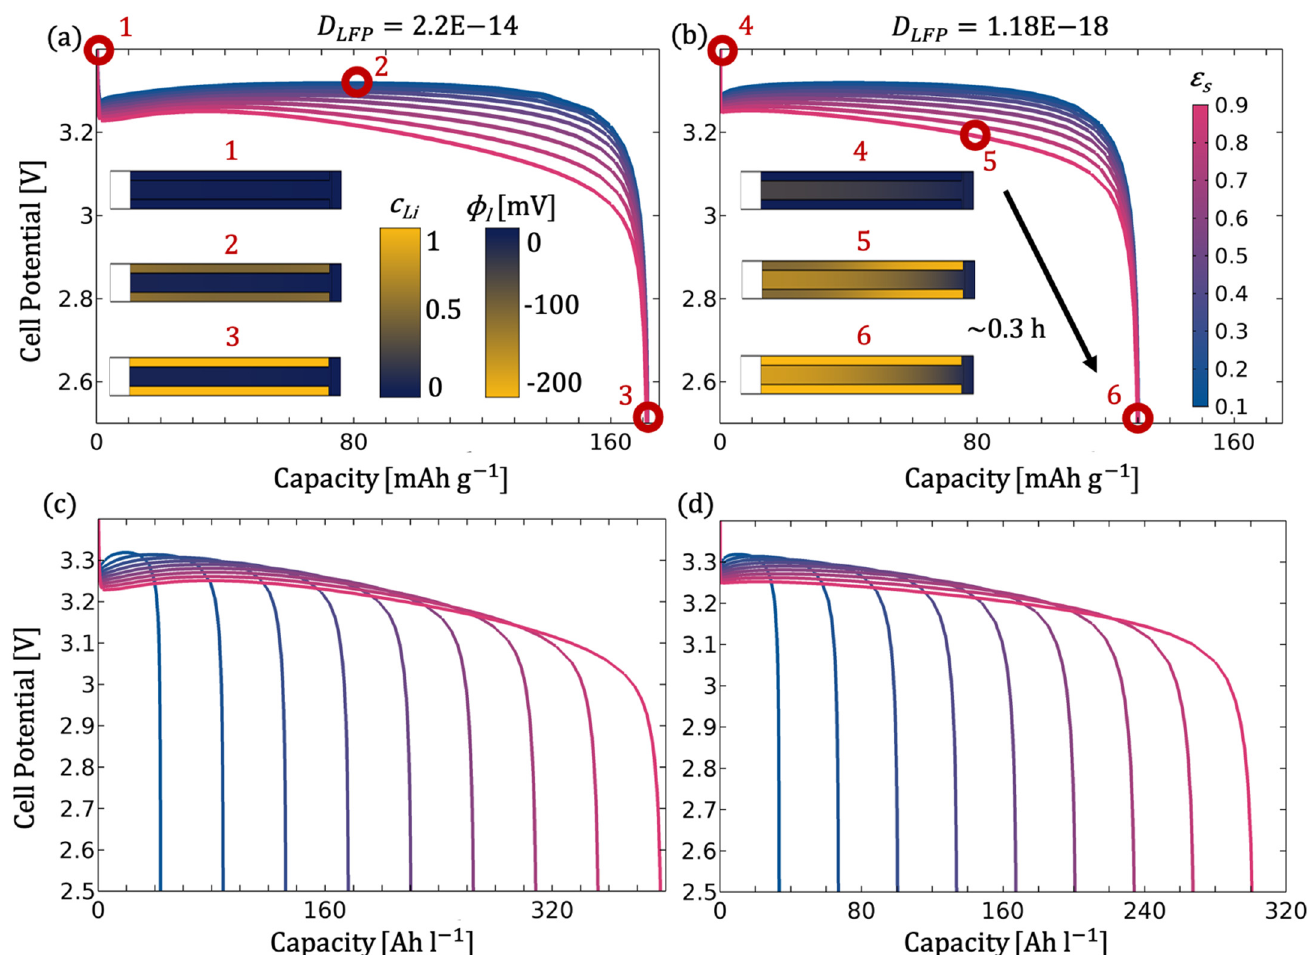
Figure 15. Discharge Performance of the lamella structure at 1C related to the gravimetric ( a , b ) and volumetric capacity ( c , d ) at D LFP = 2.2 × 10 − 14 ( a , c ) and D LFP = 1.18 × 10 − 18 ( b , d ) depending on the solid content ε S . The circle markers identify the specific time points shown in the corresponding 2D plots. The lamella shows the normalized concentration of Li ions C Li , and the transport channel shows the electrolyte potential φ l . Points 2 and 5 represent the time after 30 min discharge.